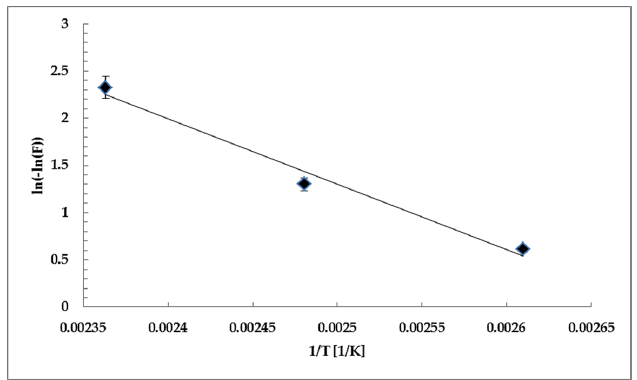
Figure 4. Temperature dependence and linear regression of PEG extraction after four hours’ supercritical debinding under 40 MPa.